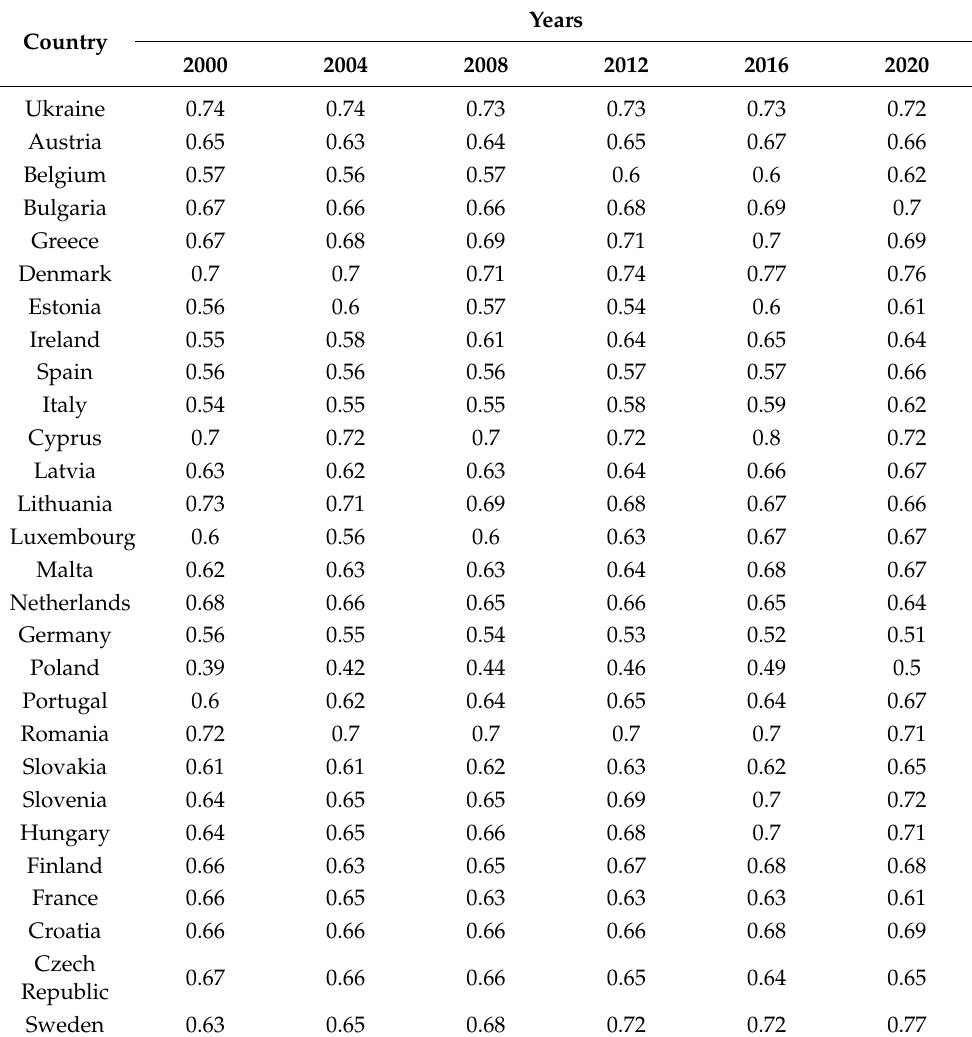
Table 5. Results of the calculation of the integrated energy efficiency index of the national economy of Ukraine and the EU,